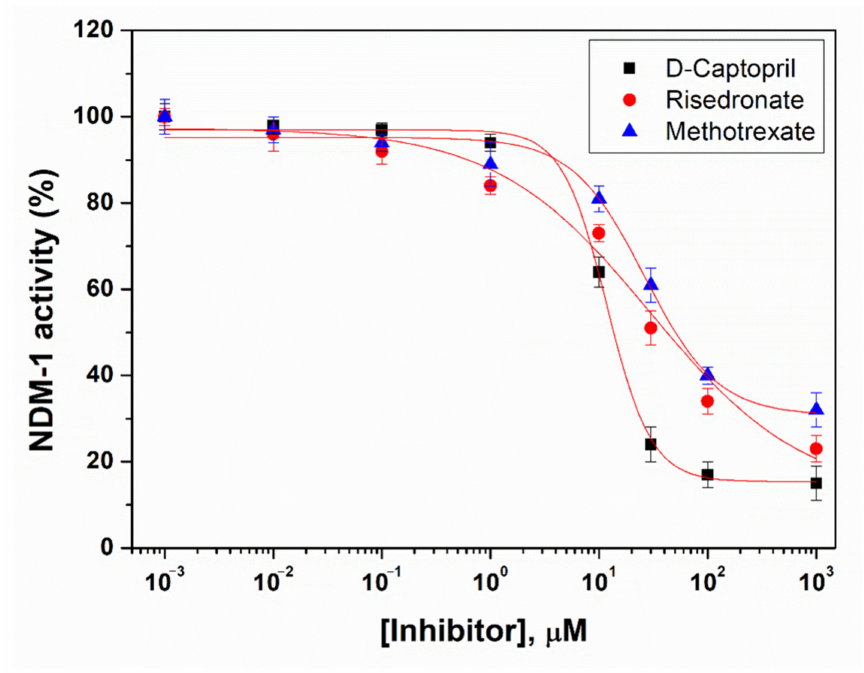
Figure 7. The IC 50 curves of risedronate and methotrexate, as compared to a known inhibitor (D-captopril) of NDM-1.